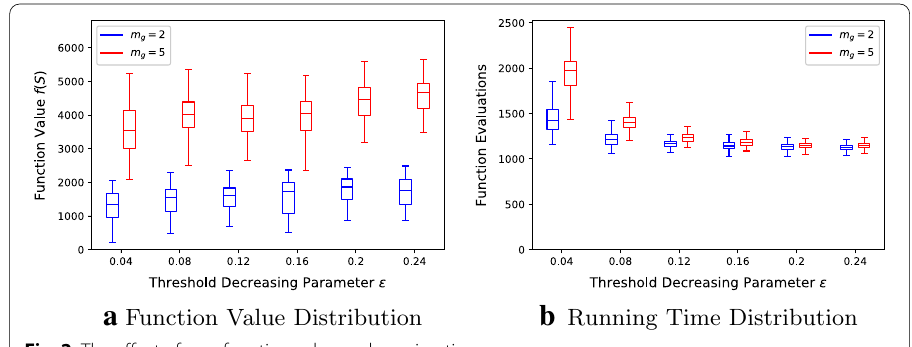
Fig. 2 The effect of ǫ on function value and running